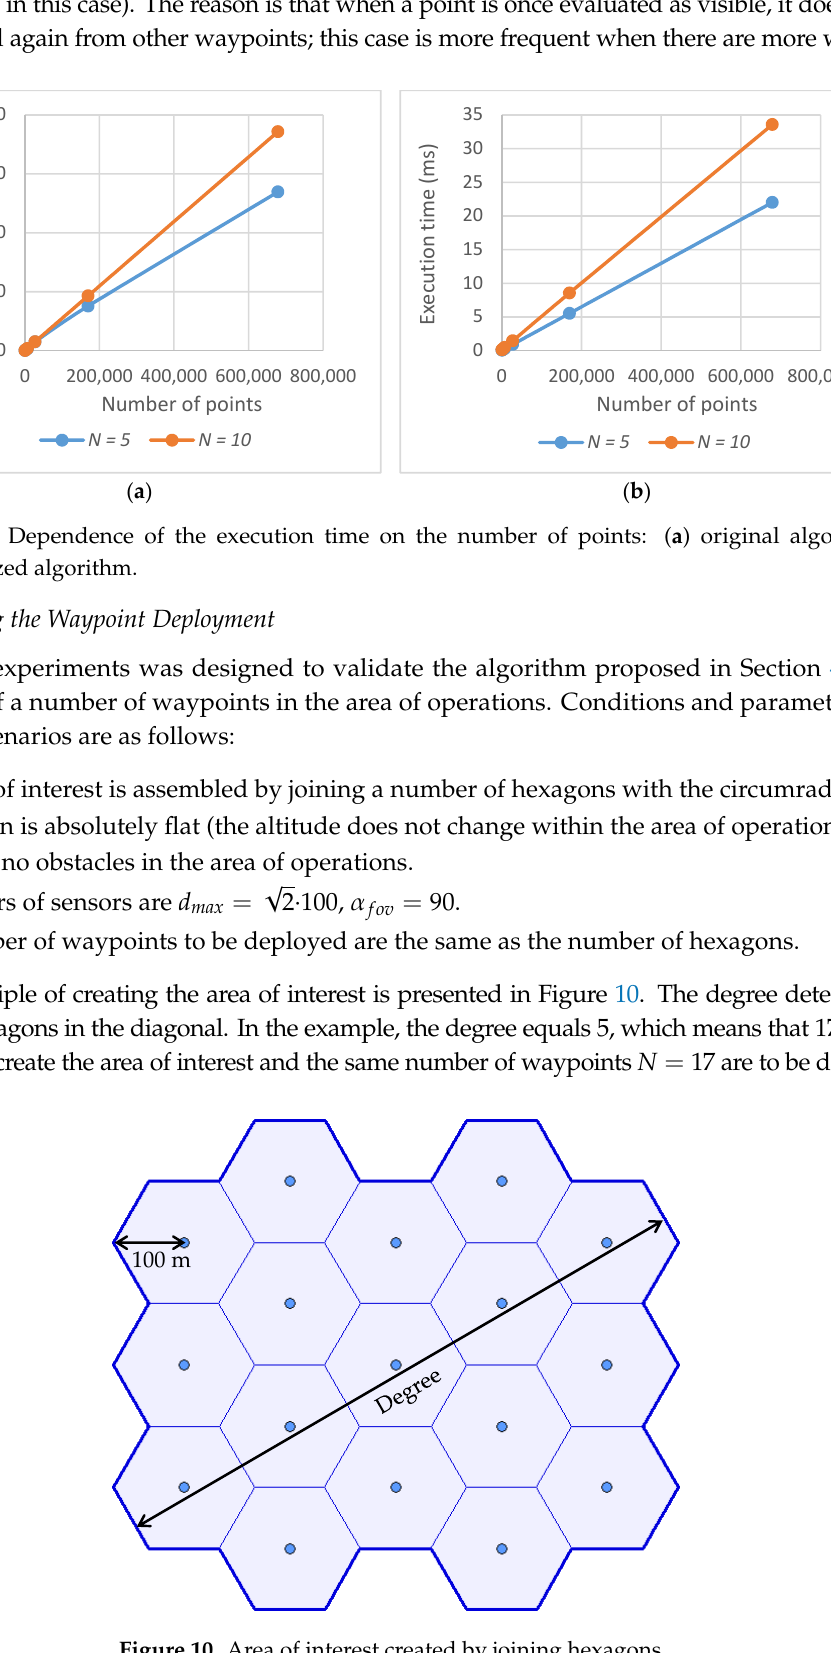
Figure 10. Area of interest created by joining hexagons.